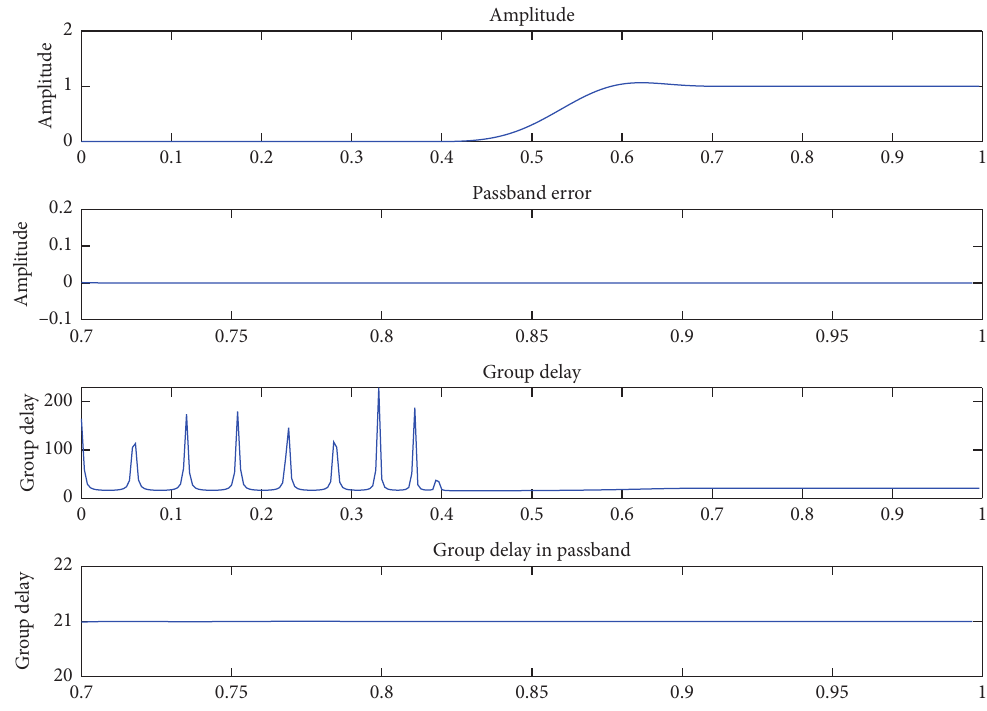
Figure 4: Performance of model reduction FIR filter for example 2.